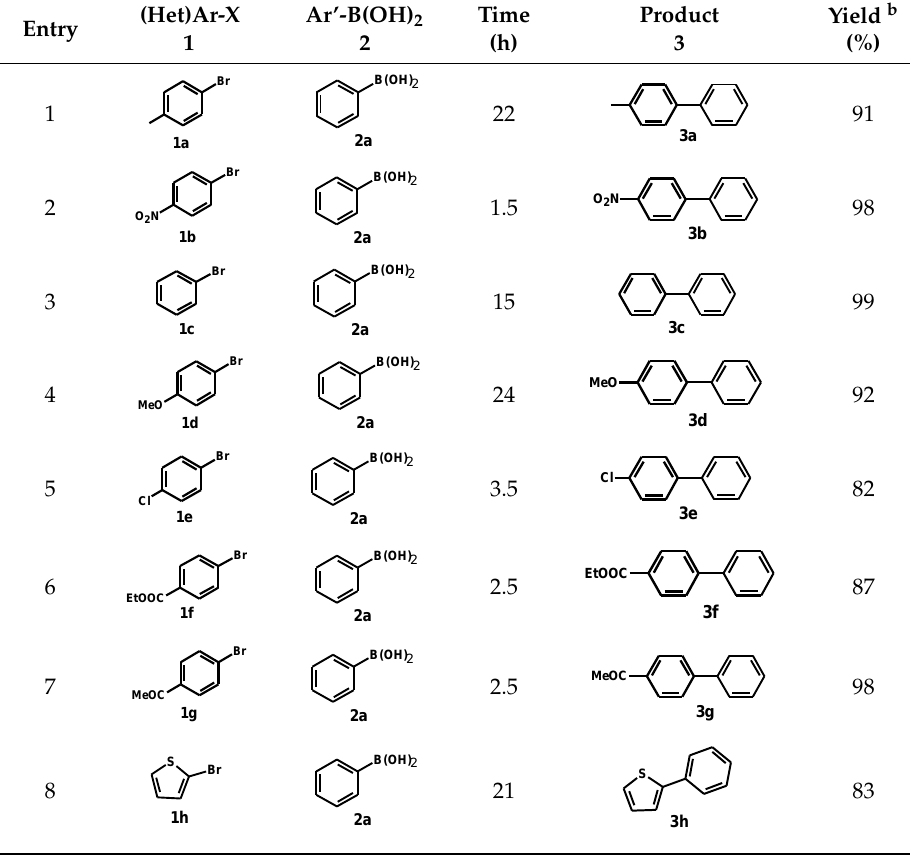
Figure 2. Conversion and hot filtration test during the Suzuki–Miyaura coupling reaction of 4- bromotoluene ( 1a ) with phenylboronic acid ( 2a ) over Pd/PVPy (see footnotes to Table 1 for experimental conditions).